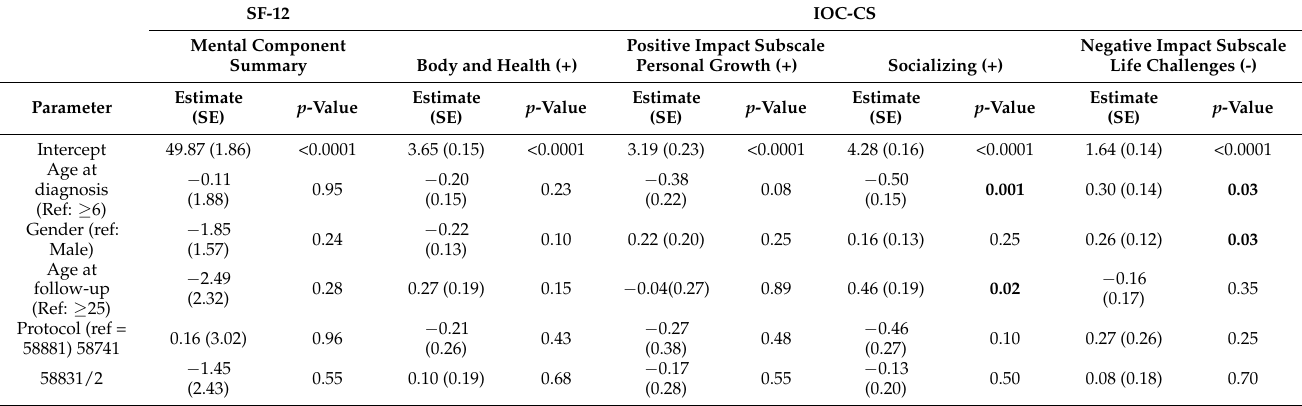
Table 3. Associations between age at diagnosis and the SF-12 mental subscale and IOC-CS subscales based on a multivariable regression